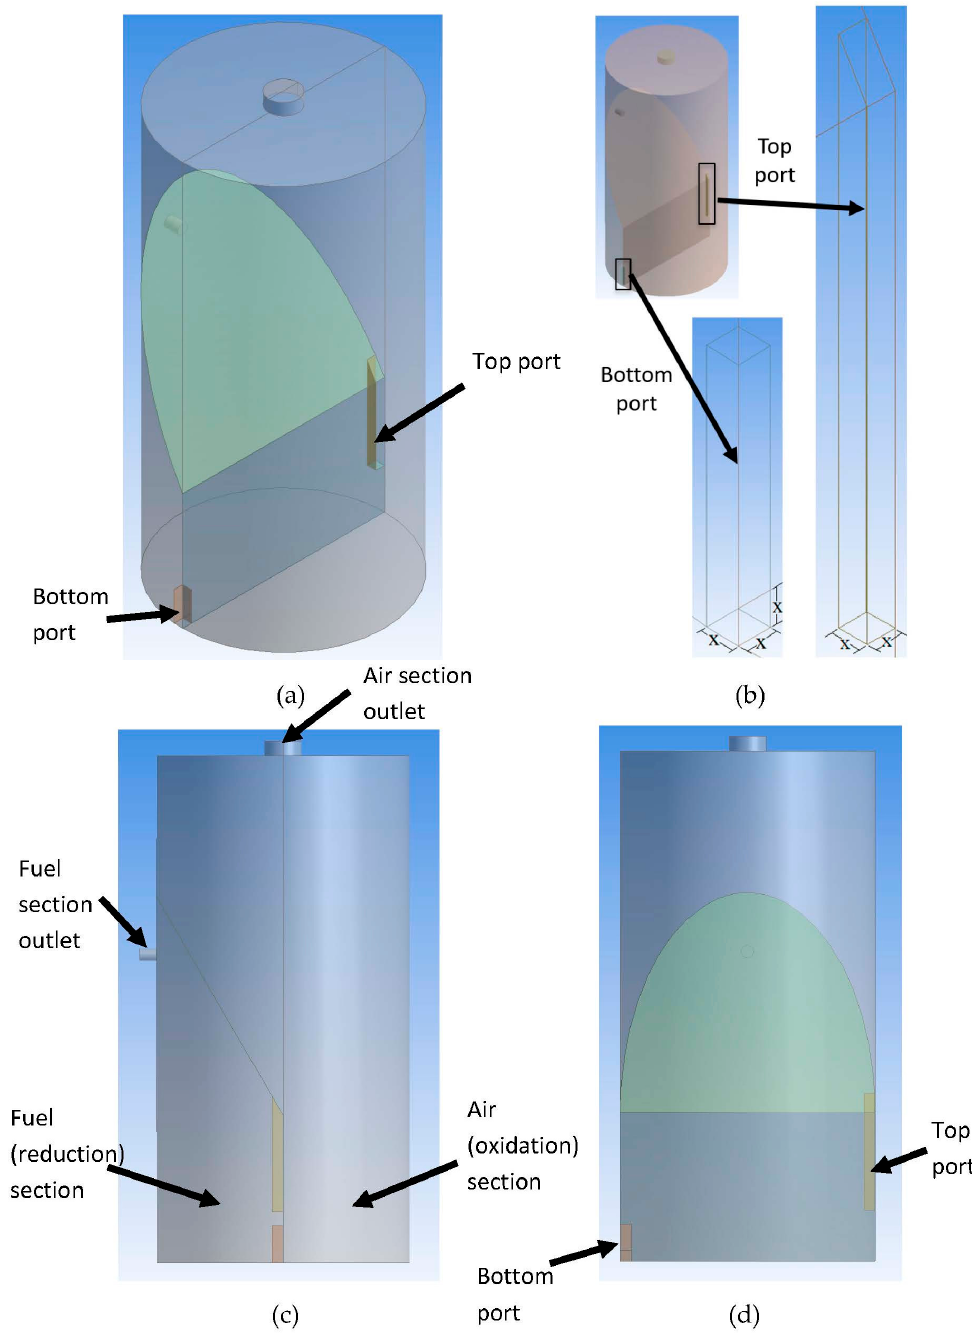
Figure 2. Simulated geometry for the internally circulating reactor (ICR): ( a ) isometric view; ( b ) details of the ports connecting the reactor sections, where x is the port width; ( c ) front view; ( d ) side view.